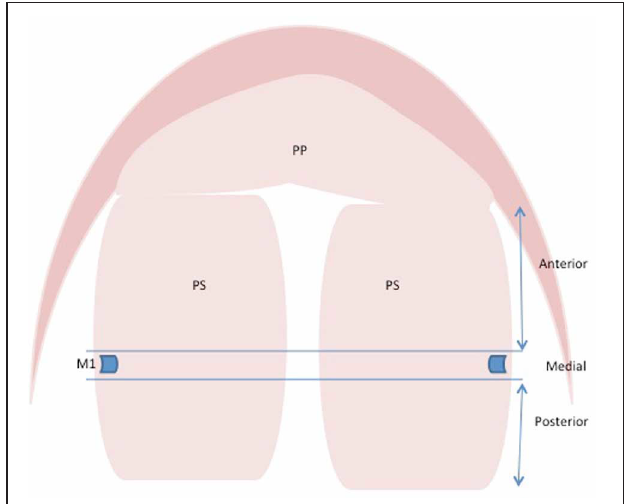
FIGURE 1 | Schematic representation for defining anterior, medial, and posterior regions of palatal shelves. Tissue anterior or posterior to first molar tooth is considered anterior or posterior palate, respectively. The palatal tissue in the region of first molar tooth bud is considered medial. Abbreviations: PP, primary palate; PS, palatal shelves; M1, first molar tooth bud.